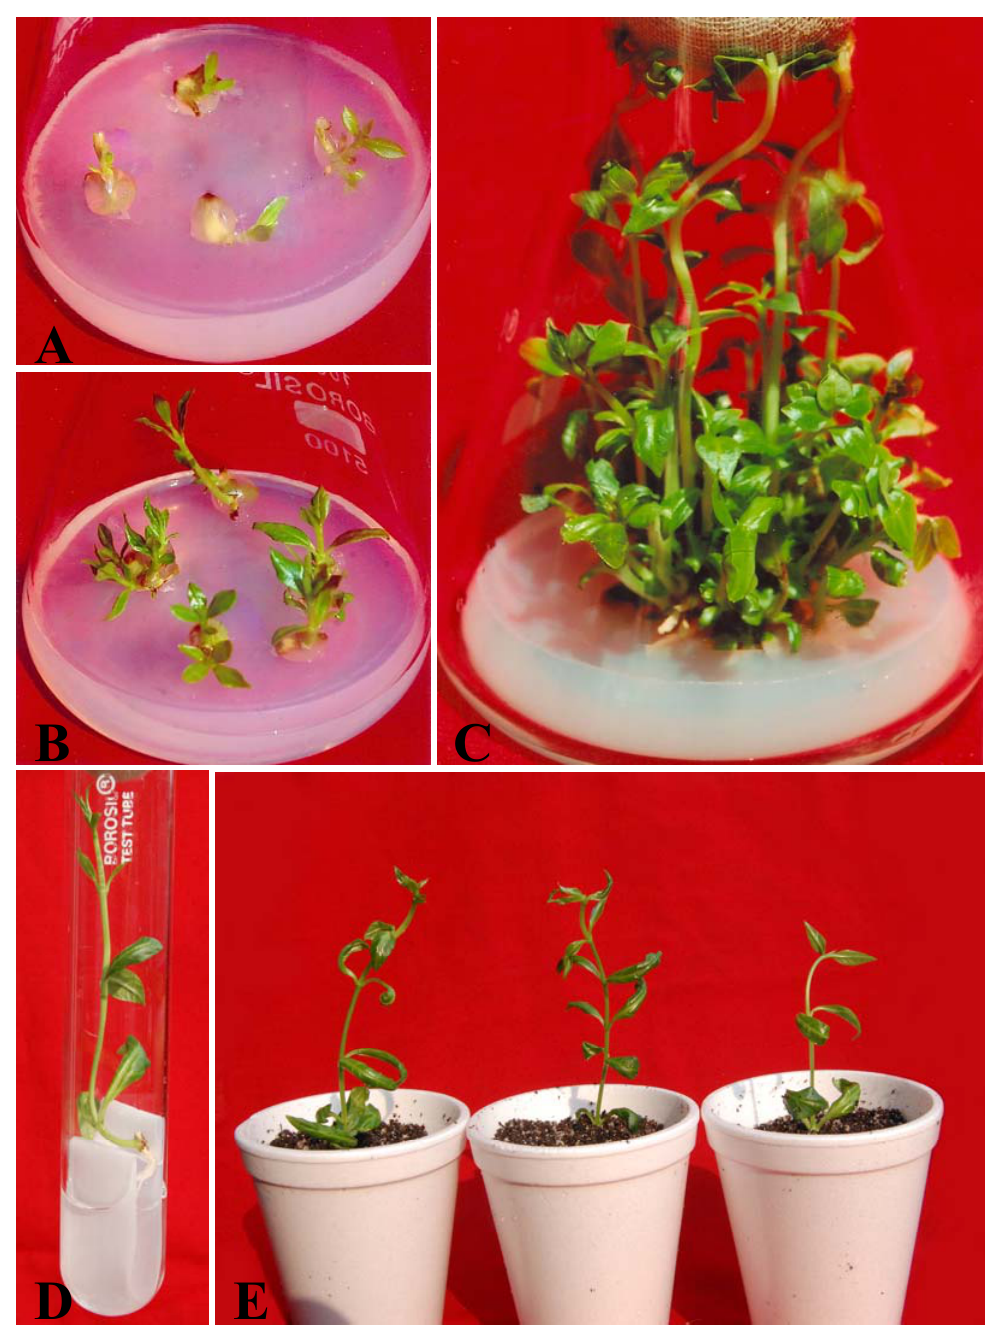
Figure 1. Plant regeneration from synthetic seeds of R. serpentina formed by the encapsulation of nodal segments in 3% (w/v) sodium alginate and 100 mM calcium chloride; A. Shoot formation from encapsulated nodal segments on WPM + 5.0 μ M BA + 1.0 μ M NAA after 2 weeks of culture; B. 3 weeks old culture showing shoot formation from synthetic stored at 4 °C for 4 weeks. Shoot multiplication from encapsulated nodal segments on WPM + 5.0 μ M BA + 1.0 μ M NAA after 8 weeks of culture; D. Rooted synseed derived plantlets. E. Acclimatized plantlets derived from synthetic